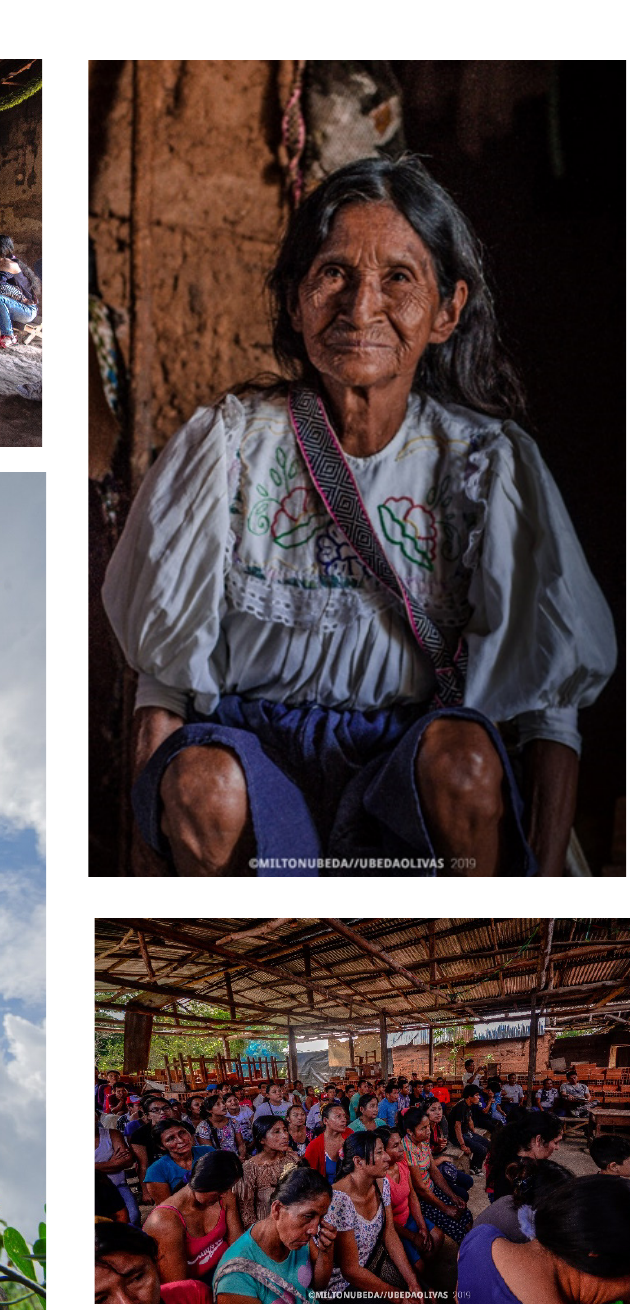
Figure 2 . Images about people and process of the